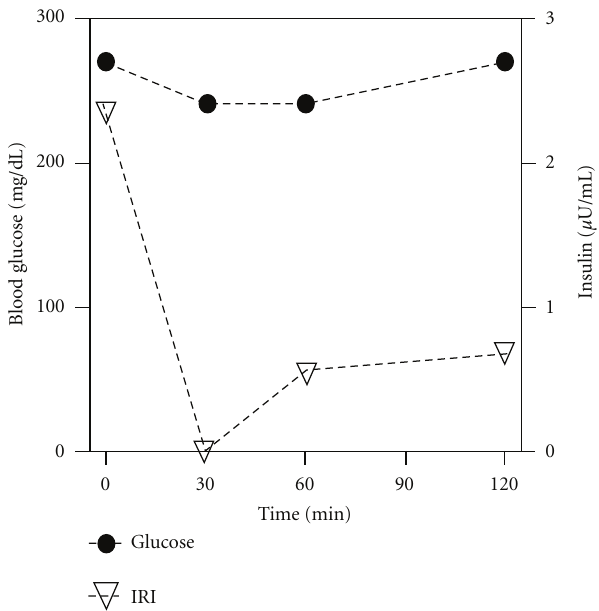
Figure 4: The e ff ects of a single dose of octreotide (50 μ g) on blood glucose and serum immunoreactive insulin levels.